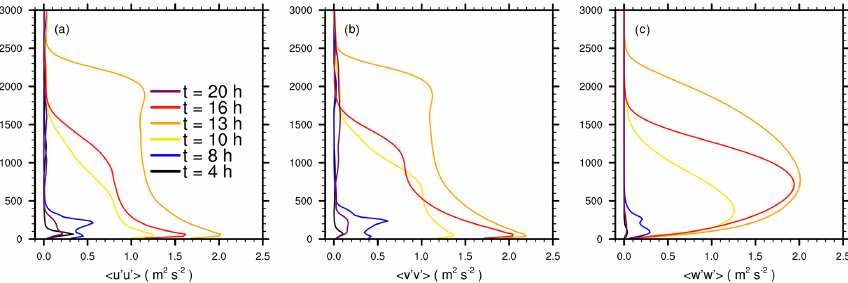
Figure 8. Variances of the velocity components: (a) for the u component, (b) for the v component, and (c) for the w component. The variance is computed from the region where the turbulent flow has been already